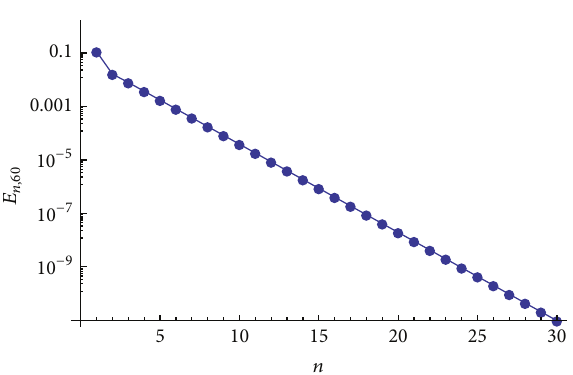
Figure 2: Approximate solution for Example